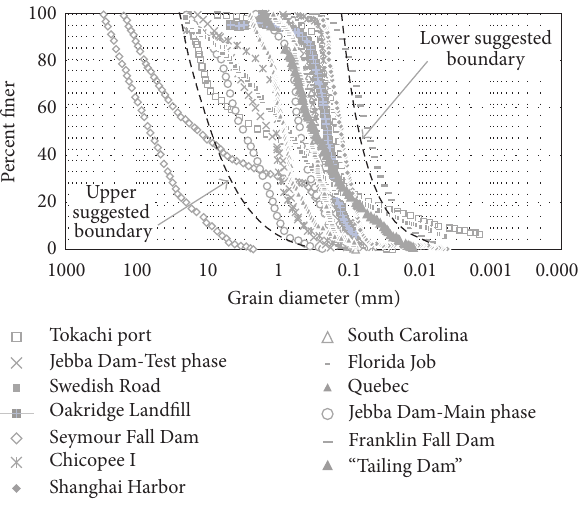
Figure 11: Suggested grain size zoning for soil improvement by EC.